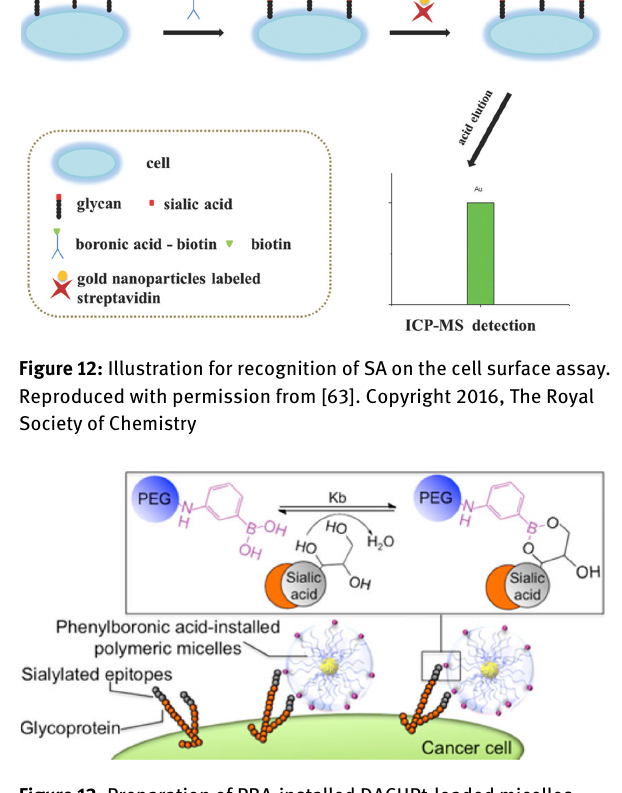
Figure 13: Preparation of PBA-installed DACHPt-loaded micelles by self-assembly of polymer-metal complex in distilled water. PBA moieties on the surface of micelles can bind to SA. Reprinted with permission from [55]. Copyright 2013, American Chemical Society